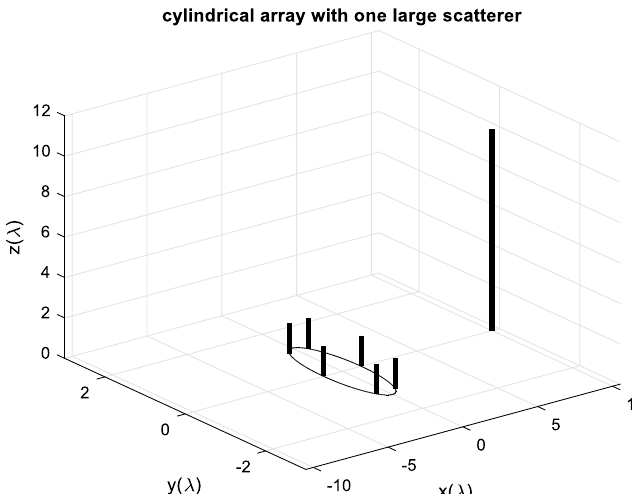
Fig. 2 The geometry of the cylindrical array with a single cylindrical scatterer in this work